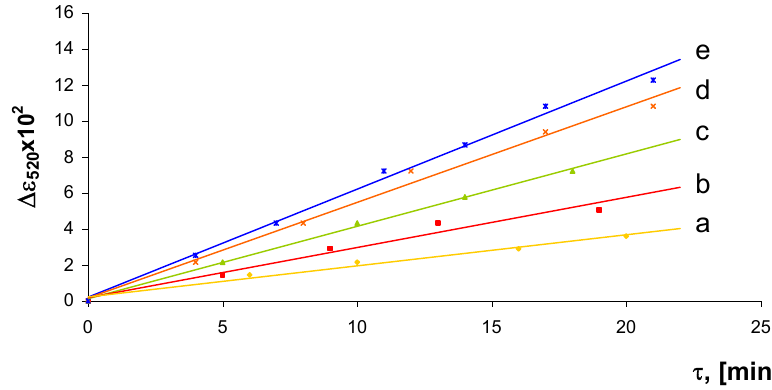
FIGURE 4. Kinetics of urea decomposition with immobilized urease and indicator on a triacetylcellulose membrane. Concentration in mM: (a) 100; (b) 200; (c) 300; (d) 400; (e) 500.